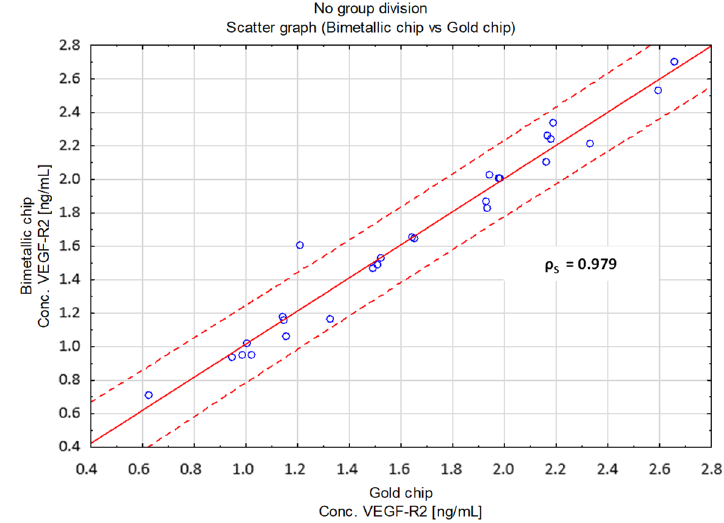
Figure 10. Scatter plot comparing both developed methods and showing Spearman’s rank correlation coefficient ρ S.